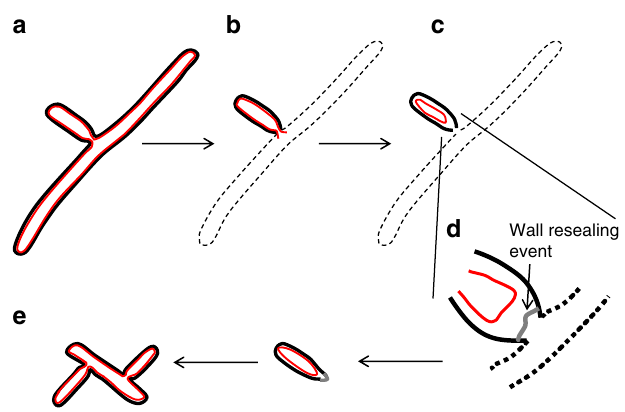
Fig. 5 Model for survival and resumption of growth of Δ ftsZ mycelial fragments. A growing branch ( a ) is attached to an underlying hyphal segment that undergoes lysis ( b ). Some of the contents of the branch are spilled, but membrane retraction and resealing results in survival of the branch ( c ). Presumably, the peptidoglycan wall is initially punctured, but it may be that the narrow diameter at the branch-site limits the amount of wall repair that is needed to enable restoration of turgor ( d ). Finally, the sealed segment resumes growth by formation of one or more de novo branches on its surface ( e ). Black lines represent the cell wall; red lines represent the cell membrane. Note that this would be a rare event and most mycelial fragments of the ftsZ mutant are destroyed by mechanical